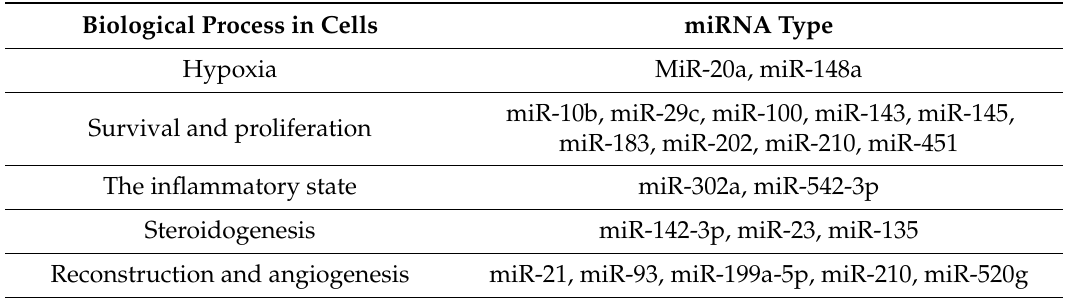
Table 1. MicroRNAs (miRNAs) involved in the development of